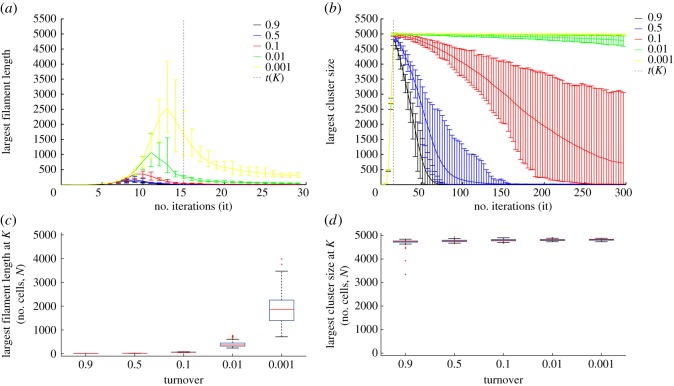
Cluster size at carrying capacity for various turnovers in one and two dimensions. (a) The longest filament length (cells) in one dimension and (b) the largest cluster size (cells) in two dimensions as a function of the number of iterations. The different colours indicate the different turnovers (from 0.001 in yellow to 0.9 in black), and the dashed line the number of iterations t(K) at which the carrying capacity is reached (in both cases, this occurs at the 15th iteration, because the growth curve for all turnovers in both dimensions is the same; see also figure 3). In contrast to filaments growing in one dimension, clusters in two dimensions can reach larger sizes and maintain them for a longer time. The central mark shows the mean and the extremes of the error bars represent the upper and lower limits of 95% of the data points. (c,d) Box plots of the largest filaments and cluster sizes at carrying capacity (at the 15th iteration) for one and two dimensions, respectively. The central bar represents the median, the edges of the box show the 25th and 75th percentiles, the whiskers extend to the extreme data points not considered outliers, and the outliers are plotted individually as red crosses.